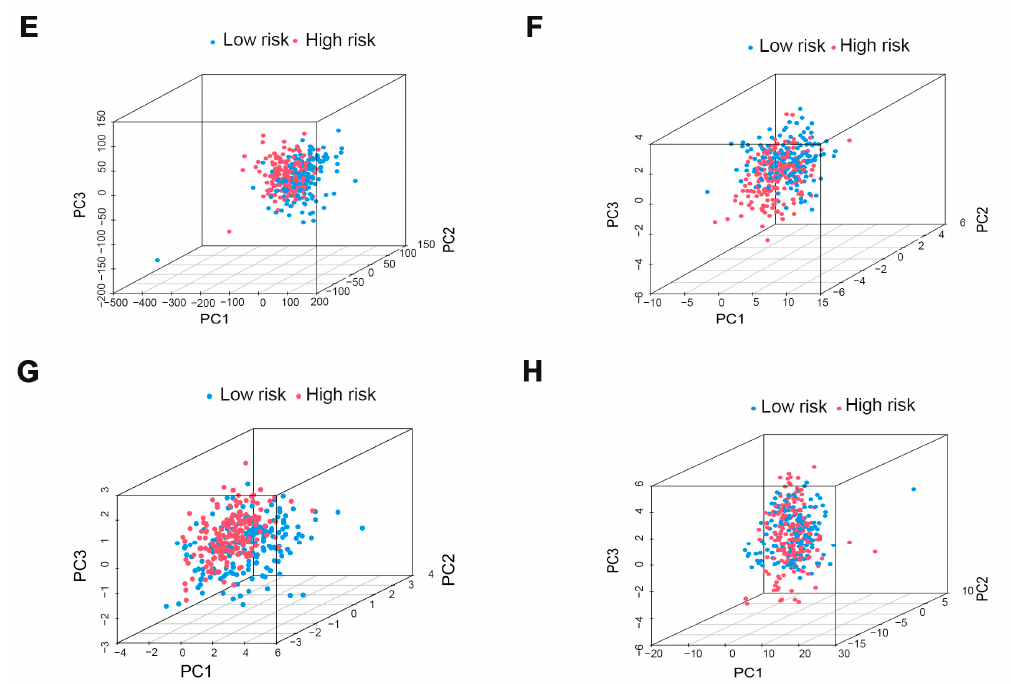
Figure 4. The prognostic ability of four cuproptosisrelated glycosyltransferases in COAD patients was verified. Univariate ( A ) and multivariate ( B ) COX regression analysis showed that risk score could be utilized as a prognostic factor. ( C ) The calibration curve predicted the patient’s OS at 1, 3, and 5 years in all samples. ( D ) C-index curves were used to assess the discrimination between the risk scores and other clinical features at different time points. PCA shows the sample distributions of all genes ( E ), cuproptosis-related genes ( F ), glycosyltransferases ( G ), and four cuproptosis-related glycosyltransferases ( H ) .